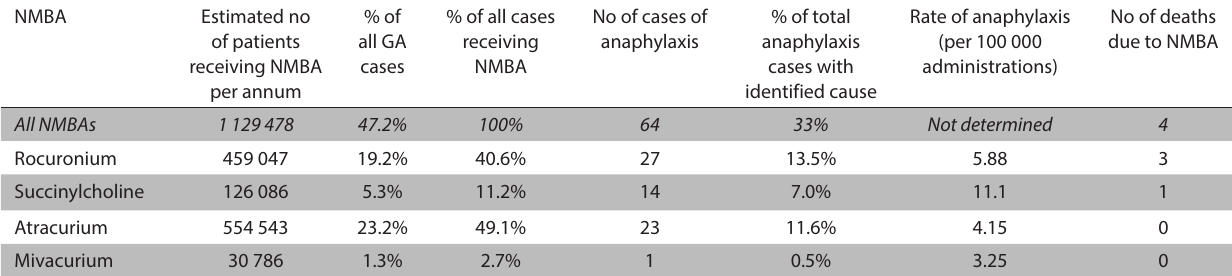
Table 3: Summary of NAP6 results regarding NMBAs 2,22,26 NMBA